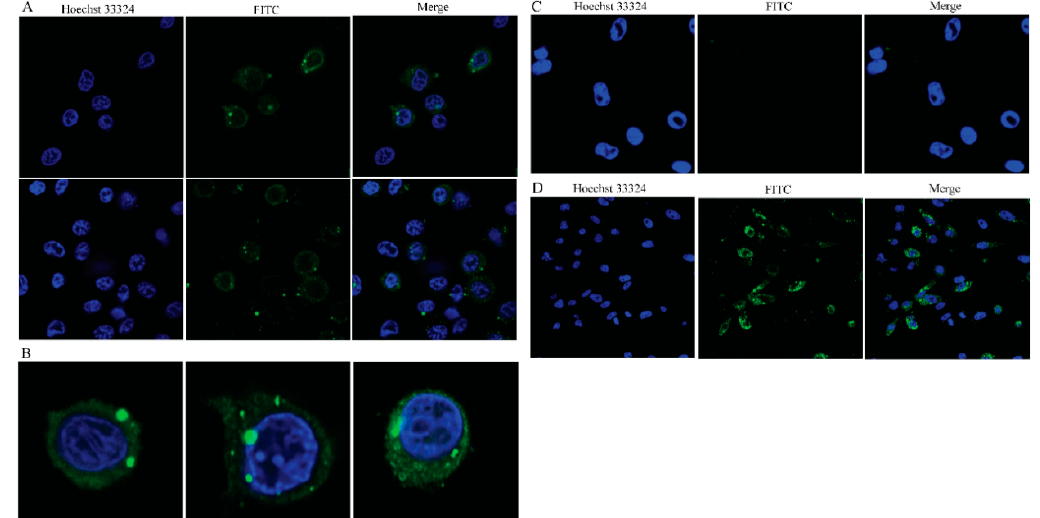
Figure 6. Immunofluorescence of GCRV-II infected peripheral blood cells. ( A ) Fluorescent labeling of the GCRV-II vp4-protein (green) in ex vivo infected leukocytes, the nuclei were stained with Hoechst (blue). Confocal microscopy of different staining patterns in the cytoplasm, including a few inclusions and scattered granular staining in the perinuclear region (scale bar: 10 μ m). ( B ) Confocal microscopy images showing viral inclusions in the perinuclear area. ( C ) Fluorescent labeling of the GCRV-II vp4-protein (green) in ex vivo infected erythrocytes, the nuclei were stained with Hoechst (blue). Confocal microscopy images showing erythrocytes were GCRV negative (scale bar: 10 μ m). ( D ) Fluorescent labeling of the GCRV-II vp4-protein (green) in infected CIK cells, the nuclei were stained with Hoechst (blue). Confocal microscopy images showing many virus inclusions were found in the cytoplasm (scale bar: 20 μ m).